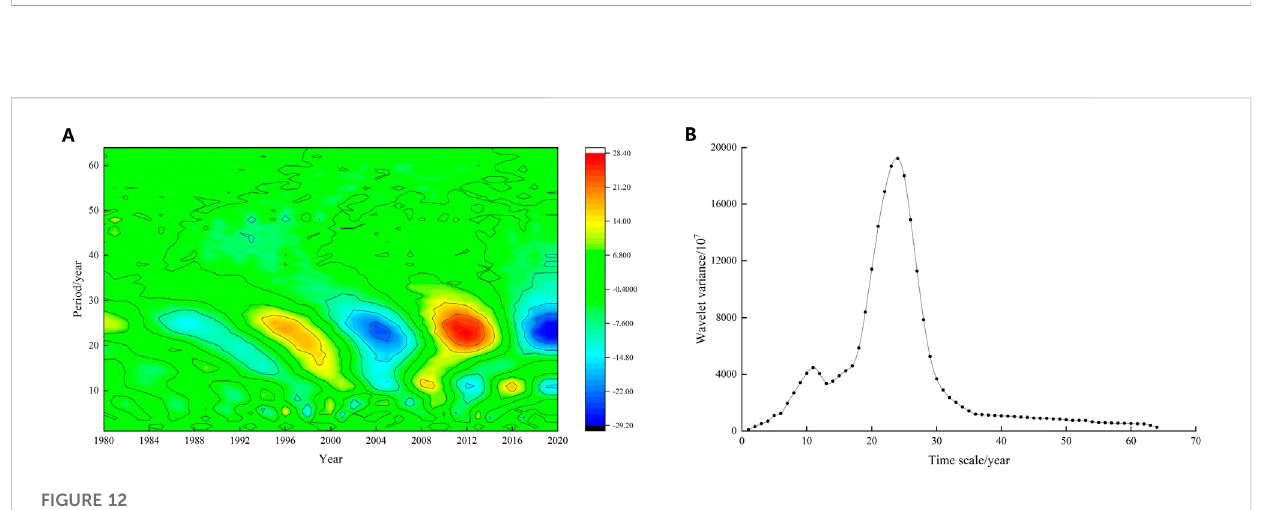
Annual variation in the sediment load and anomalies in the Nandu River Banner.